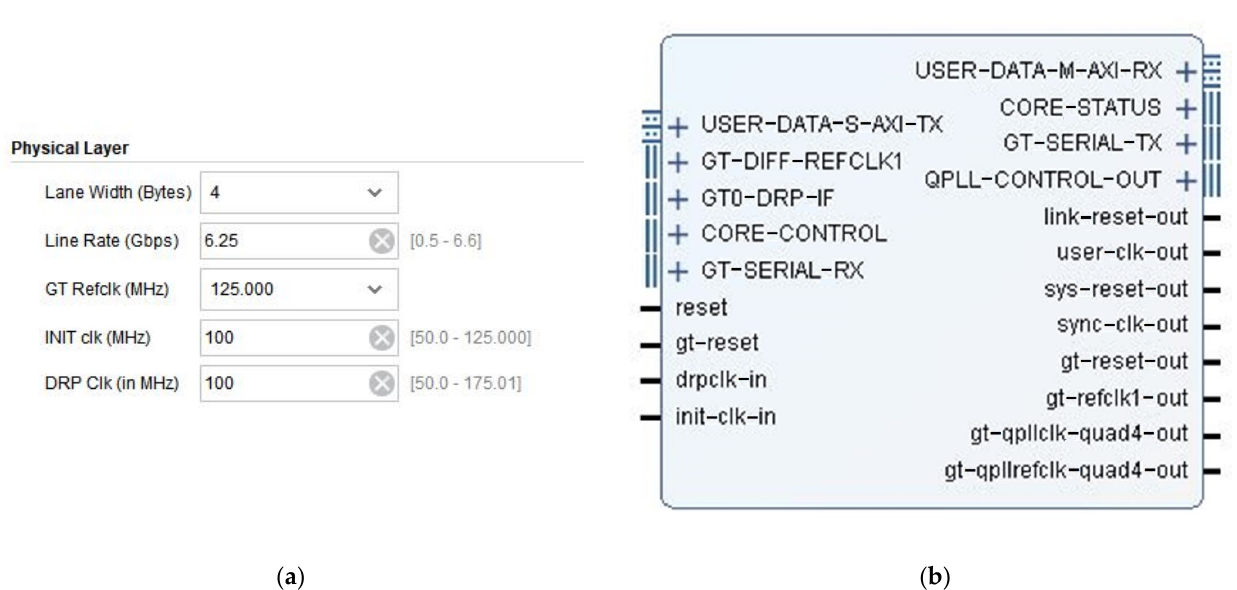
Figure 4. ( a ) Aurora IP core design configuration parameters; ( b ) Aurora IP core schematic diagram.